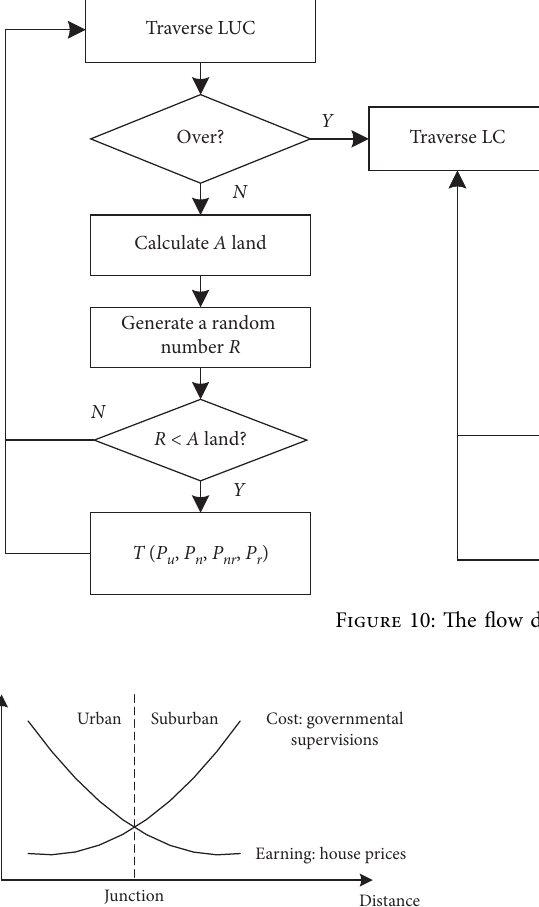
Figure 11: Filling in lakes by the real estate developer agent tends to gather around the junction zone because of house prices and governmental